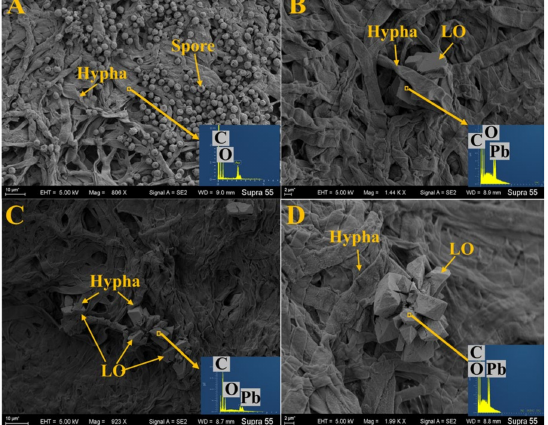
Figure 4. SEM image and EDS point data in 0 mg/L ( A ), 500 mg/L ( B ), 1000 mg/L ( C ), and 1000 mg/L Pb concentrations ( D ) after three days of incubation. LO: lead